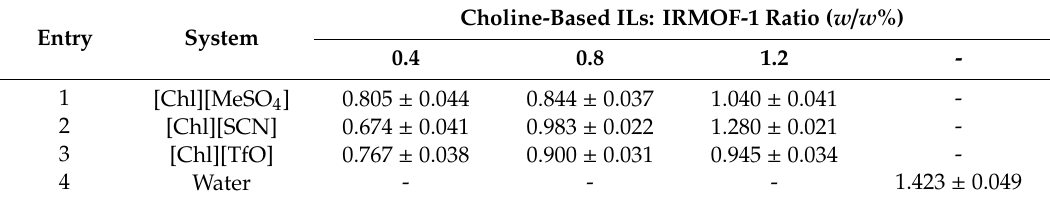
Table 2. Root mean square deviation (RMSD) value of choline-based ILs / IRMOF-1 at di ff erent weight ratios, simulated at 298 K and 1